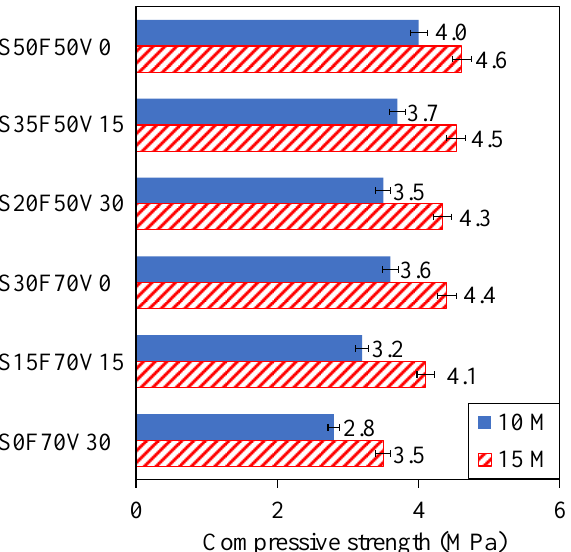
Figure 9. Compressive strengths of the geopolymer mortar at 28 days.